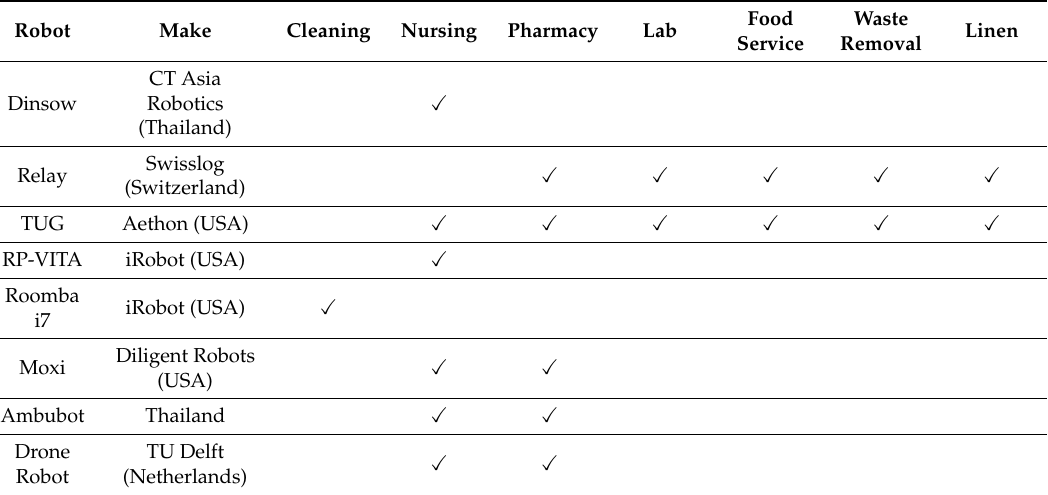
Table 1. List of prominent medical robots with